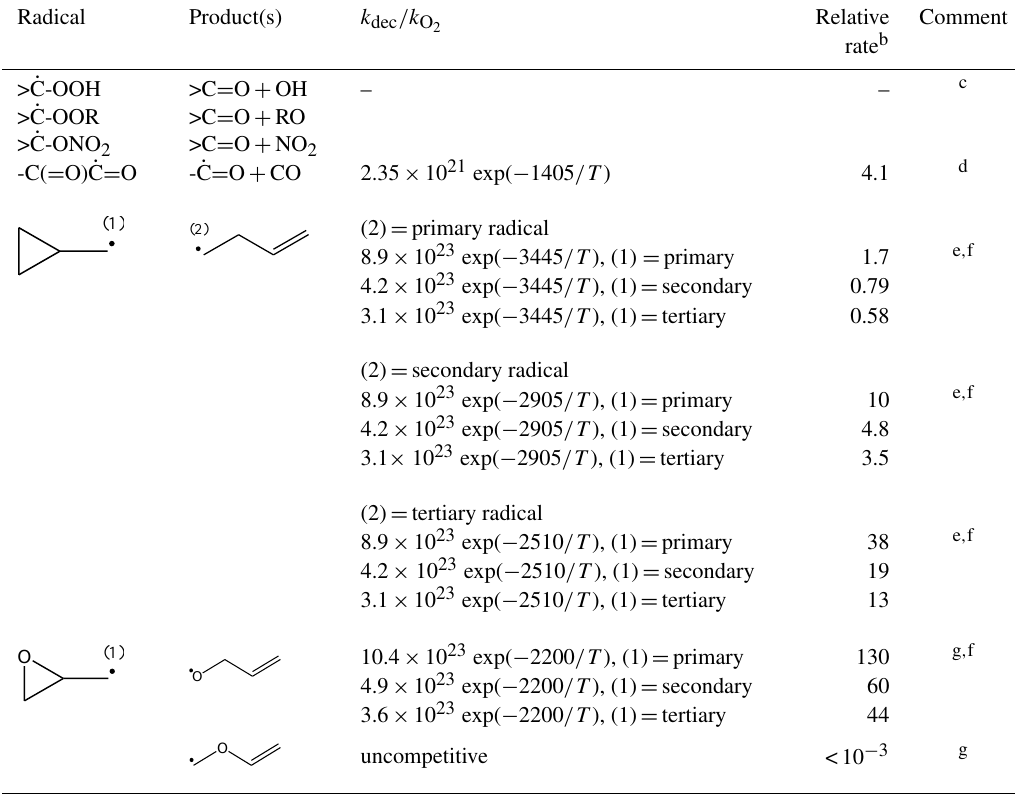
Table 14. Representative rate coefficients for rapid decomposition or ring-opening reactions of thermalized organic radicals ( k dec ), relative to those for addition of O 2 ( k O ) for primary, secondary and tertiary radicals a 2